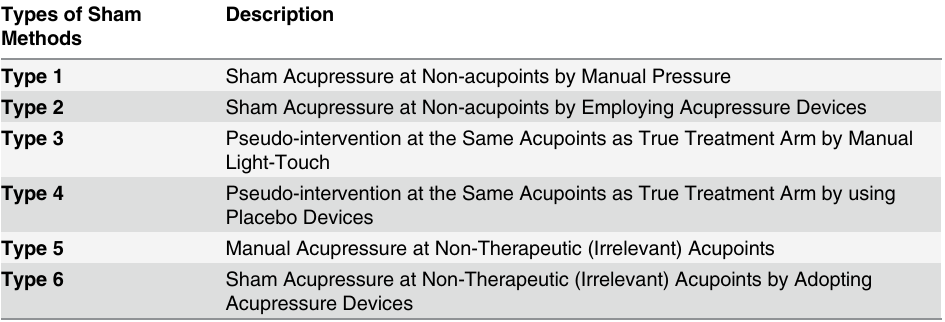
Table 1. Classification of Sham Acupressure